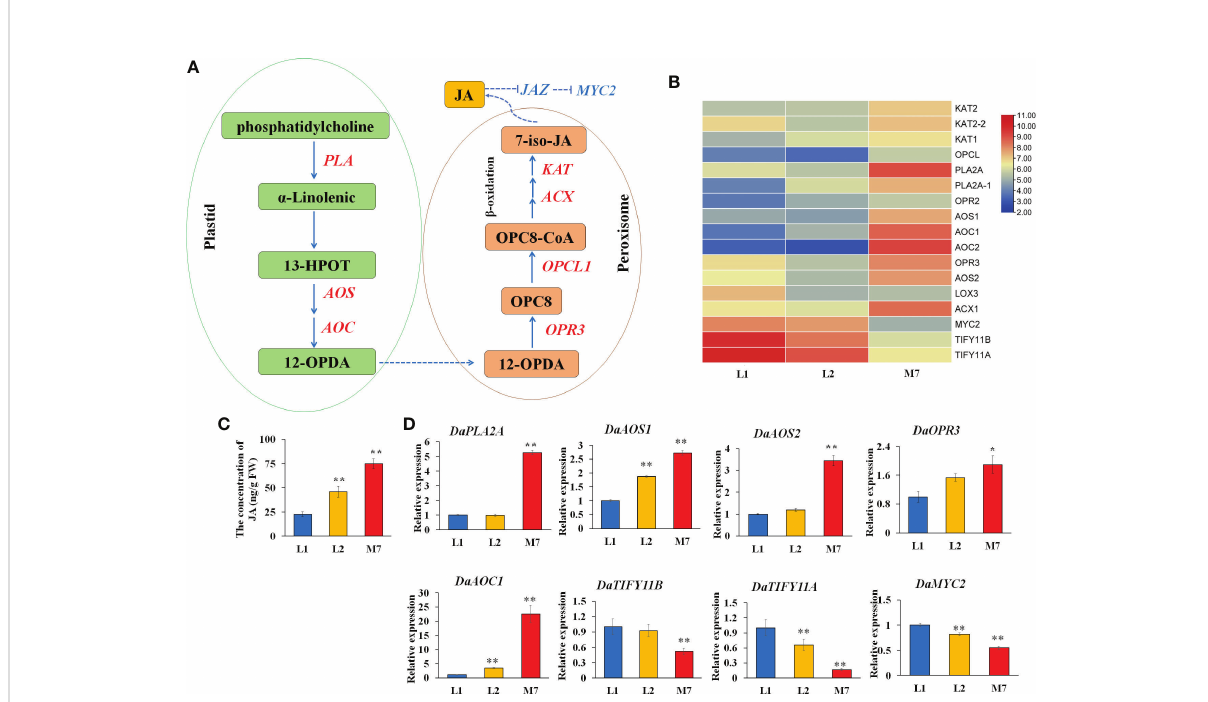
FIGURE 6 The JA biosynthesis at different developmental stages. (A) The pathway of a -linolenic acid metabolism and JA biosynthesis according to the KEGG database. (B) The heat map of genes associated with a -linolenic acid metabolism and JA biosynthesis based on their expression level. (C) .The concentration of JA during root development. (D) The expression of genes DaPLA2A, DaAOS1, DaAOS2, DaOPR3, DaAOC1, DaTIFY11B, DaTIFY11A , and DaMYC2 during root development. AOS, allene oxide synthase. The values of (C, D) are the means ± SD; n = 3. Statistical analyses were performed using Student ’ s t test compared with L1. **, P < 0.01, *, P < 0.05. OPR3, 12-oxophytodienoic acid reductase; PLA2A, Phospholipase